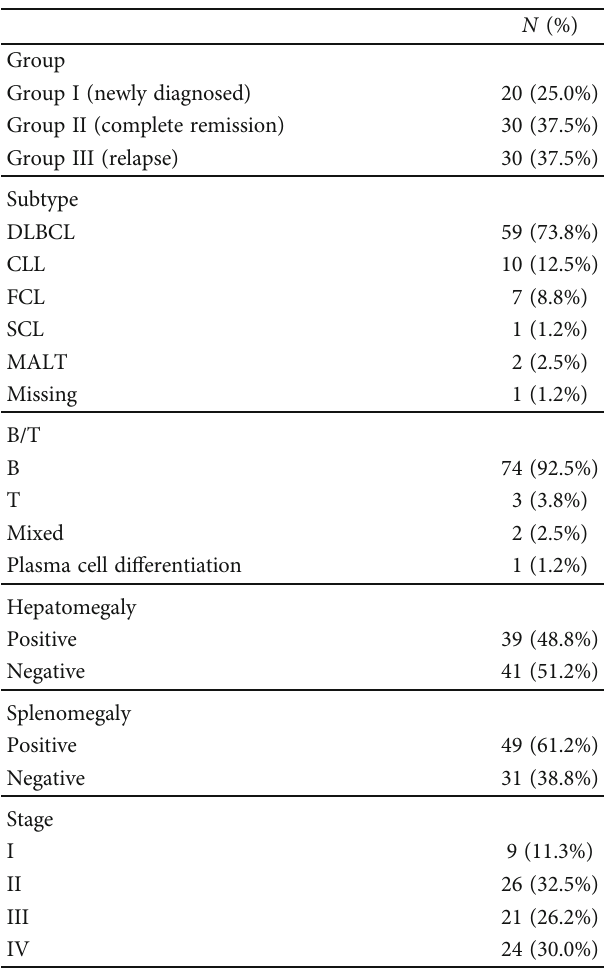
Table 1: Clinical characteristics of non-Hodgkin ’ s lymphoma (NHL)